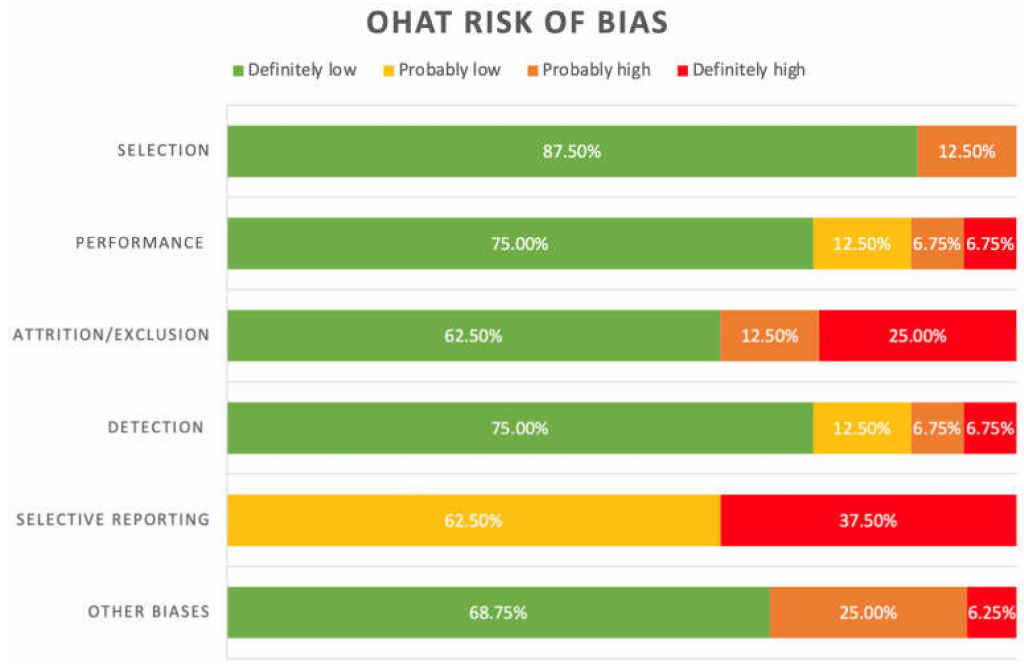
Figure 2. Summary of risk of bias assessment of included studies under the OHAT